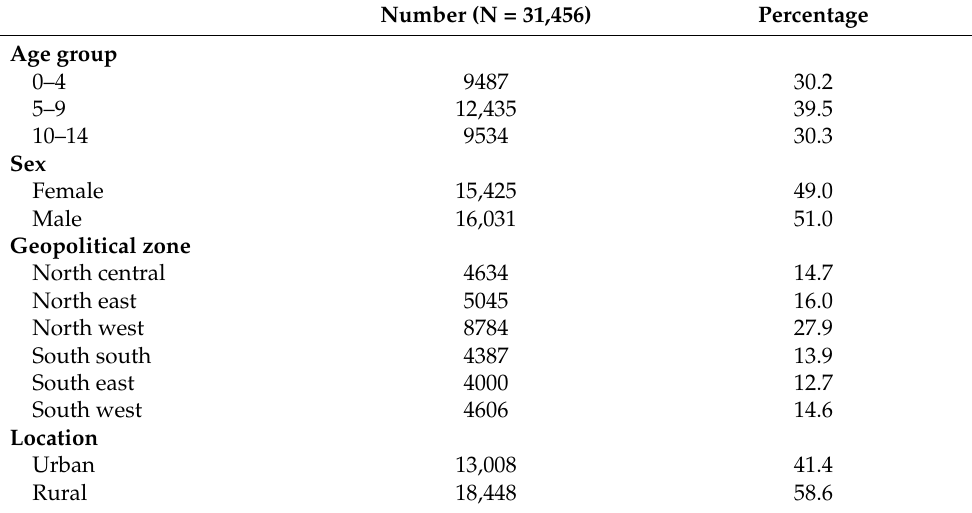
Table 1. Demographic characteristics of children tested for tetanus and diphtheria, Nigeria,